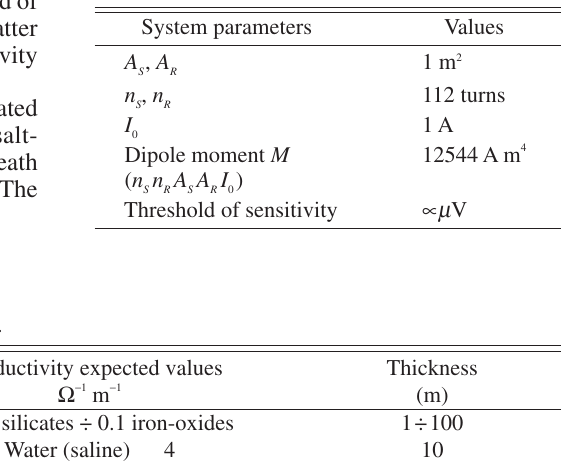
Table II. System parameter settings.